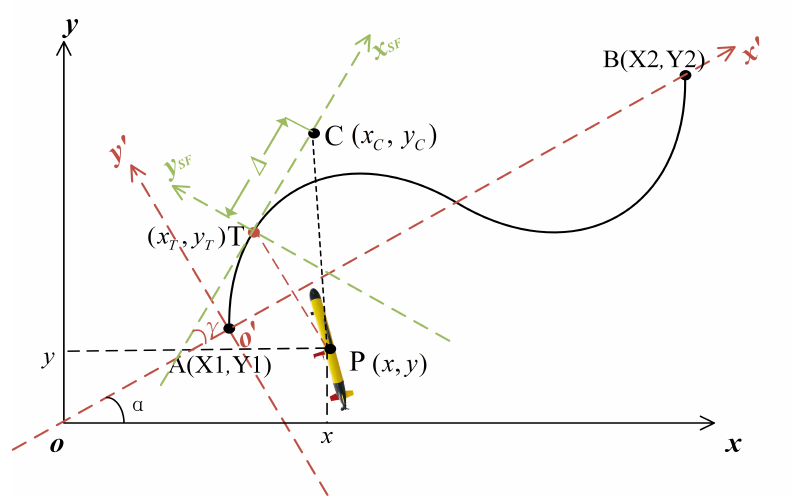
Figure 4. Path following model based on